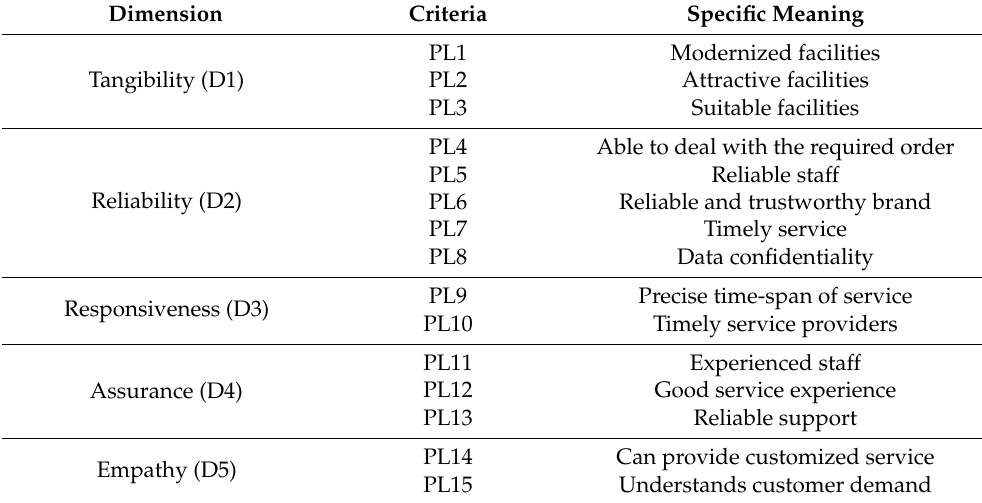
Table 1. The criteria